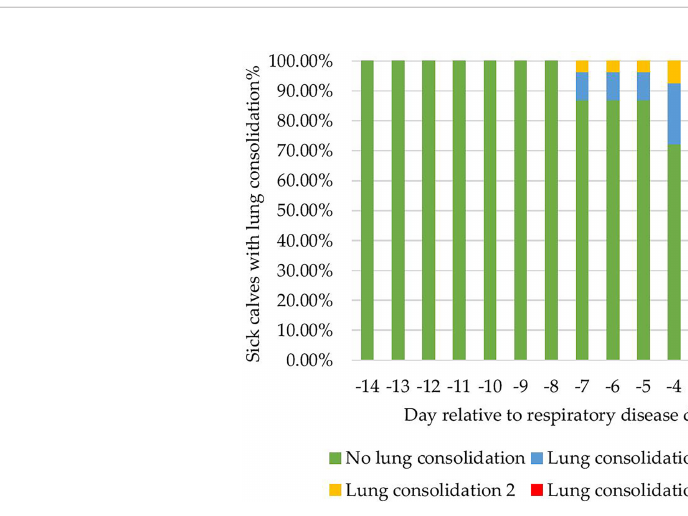
algorithm performance (training 80% testing 20% data